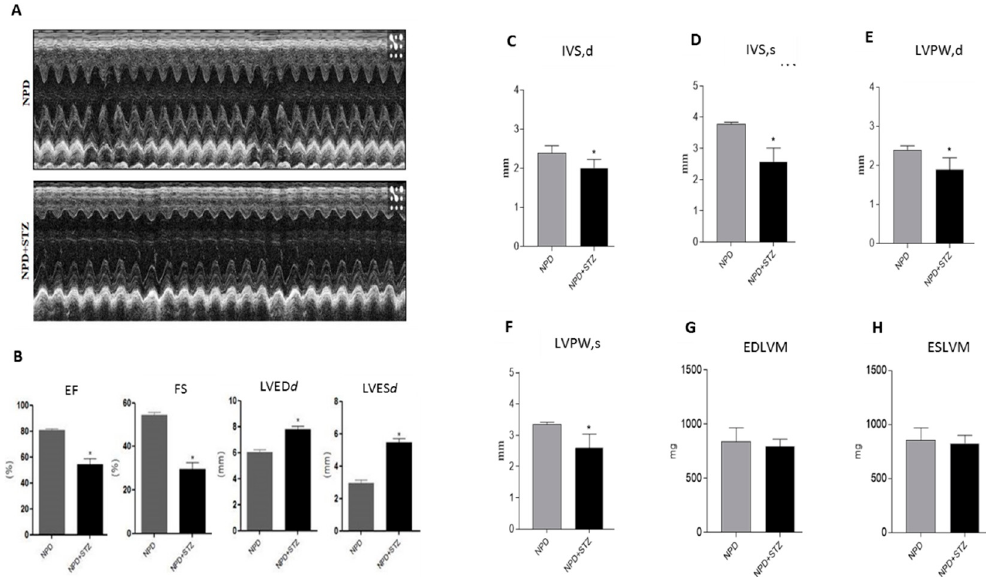
Figure 1. Effects of hyperglycaemia on left ventricle (LV) ‐ dysfunction. ( A ) Representative monodimensional echocardiographic imaging of normal pellet diet (NPD) and NPD + streptozotocin (STZ) groups at the end of the study. ( B ) Histograms show cardiac dimensions and functional parameters assessed at the end of the study. Hyperglycemia in NPD + STZ rats significantly increased LV end ‐ systolic diameter (LVES d ) and LV end ‐ diastolic diameter (LVED d ), impairing fractional shortening (FS) and ejection fraction (EF) as compared with the NPD group. ( C , D ) In NPD + STZ animals, a significant thinning of interventricular septum in systole (IVSs) and in dyastole (IVS d) and ( E , F ) the reduction of left ventricular posterior wall in systole (LVPW s) and in diastole (LVPW d) were detected in comparison with the NPD group . ( G , H ) No differences in end diastolic left ventricular mass (EDLVM) and in end systolic left ventricular mass (ESLVM) were observed between the two groups. The data are presented as mean ± SEM. * p < 0.05 vs. NPD, Mann–Whitney test, n = 6/group.